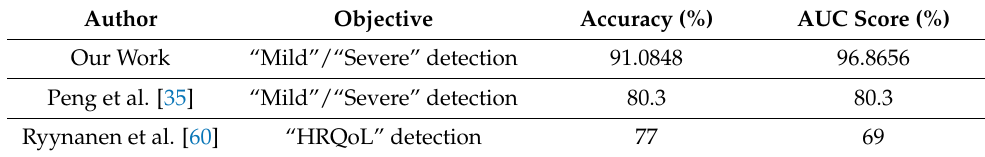
Table 8. A comparison analysis of our results with state-of-the-art models’ work for stage